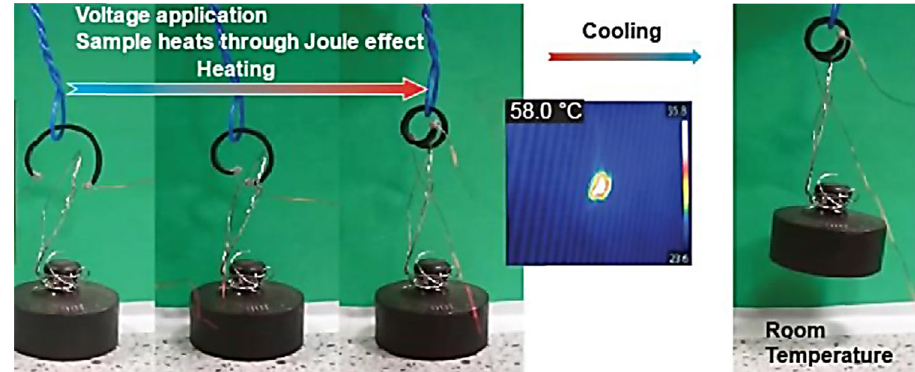
Figure 5: Infographic showing the behavior of epoxy nanocomposite subject to potential of 9 V. The composite coils back to pre - set shape after 60 s of Joule heating. The increase in temperature of sample to 58°C activated shape - memory e ff ect ( 96 ) . Reproduced with permission from Elsevier.